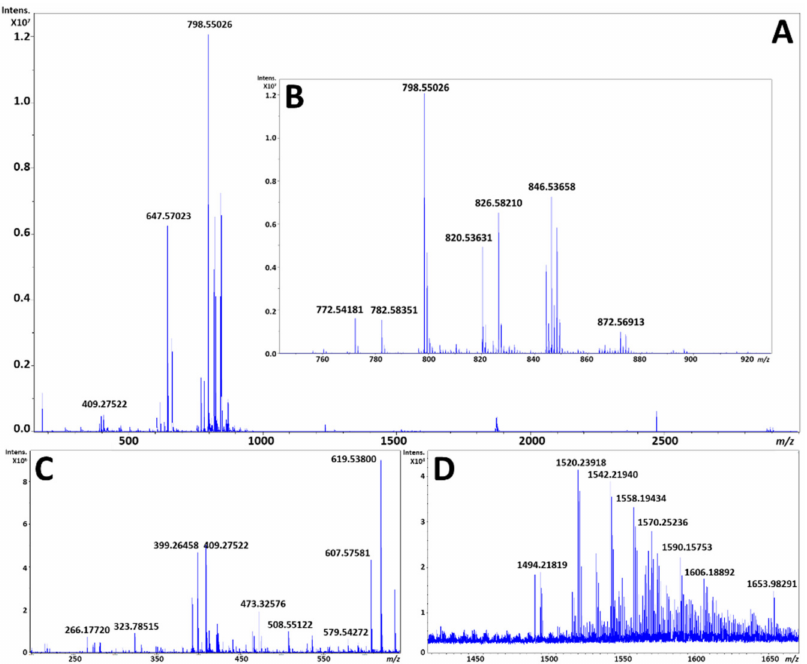
Figure 3. ( A ) is an exported average spectrum of every pixel from DESI-MSI from FlexImaging 5.0 (Bruker Daltonics, Bremen, Germany), ( B ) is a zoomed view of the phospholipid profile from m / z 700 to 900, ( C ) is a zoomed view highlighting the matrix cluster formed from 1,5-DAN in the positive ion mode from m / z 200 to 725, and ( D ) is a zoomed view of the putative cardiolipin and ganglioside profile from m / z 1425 to 1675.